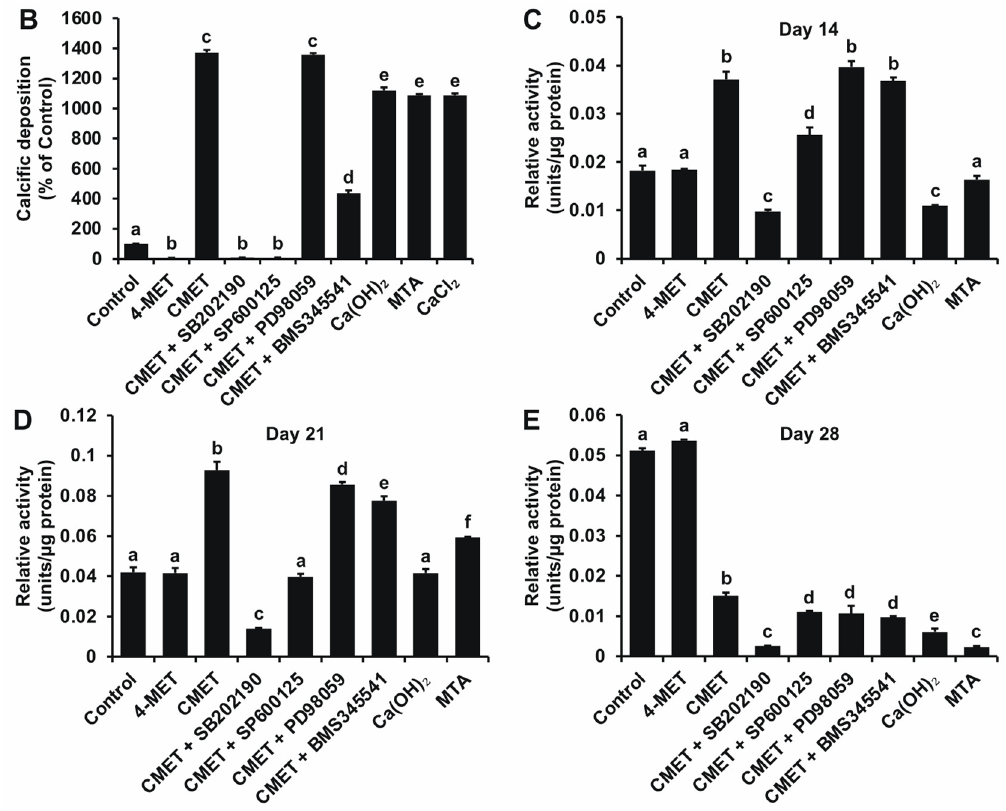
Figure 2. Mineralization-inducing ability of each material. ( A ) Photographs of mineralized nodule formation after 28 days of culture. Except for 4-MET, which inhibited cell mineralization, the other three materials accelerated the calcium nodule formation of hDPSCs. Staining of the CMET group showed a uniform appearance, while staining of the Ca(OH) 2 and MTA groups was more similar to that upon the addition of a calcium chloride solution. Inhibition of the NF- κ B pathway reduced the CMET-induced increase in calcific deposition and inhibition of the p38 and JNK MAPK pathways completely depressed hDPSCs mineralization. ( B ) Mineralized product staining intensity was determined by CPC quantification. The addition of CMET significantly enhanced the ALPase activity of hDPSCs on days 14 ( C ) and 21 ( D ) and then decreased ALPase activity on day 28 ( E ). MTA treatment slightly enhanced hDPSCs ALPase activity on day 21. 4-MET and Ca(OH) 2 treatment did not increase ALPase activity. CMET-induced ALPase activity was primarily involved p38 and JNK MAPK pathways. n = 3, different lowercase letters indicate a significant difference ( p < 0.01).